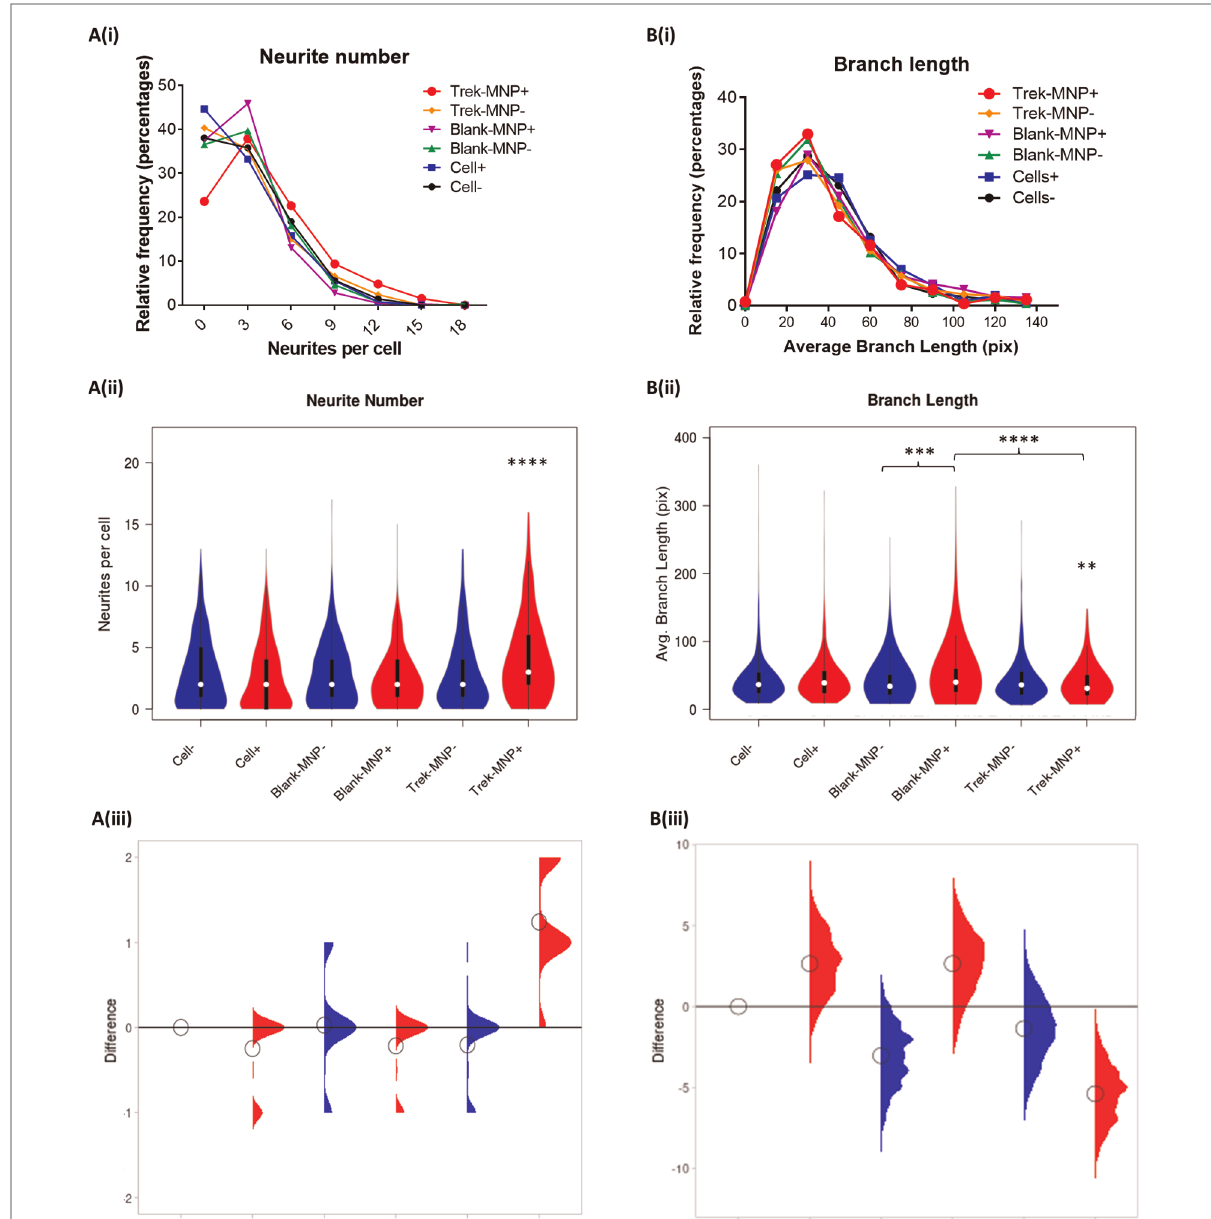
FIGURE 6 TREK-MNP increase neurite number and decrease branch length. Neurite analysis of Immuno fl uorescent images indicated that TREK-MNP with magnetic fi eld stimulation signi fi cantly increased the overall number of neurites per cell as shown by histogram ( A(i) ) and violin plots ( A(ii) ) whilst all other groups had no signi fi cant effect and remained similar to the control (cells only). The differences between the groups relative to the cells only control are shown by the median difference plots ( A(iii) ). Branch length analysis of neurites indicated that TREK-MNP (with magnetic fi eld stimulation) signi fi cantly decreased neurite branch length compared to the respective controls (cells+magnet and Blank-MNP+Magnet) as shown by histogram ( B(i) ) and violin plots ( B(ii) ). Blank-MNP+magnet marginally increased neurite branch length compared to Blank-MNP alone or TREK-MNP. The differences between the groups are shown by the median difference plots ( B(iii) ). Histograms and Violin plots represent median value (median denoted by white circles); box limits indicate the 25th and 75th percentiles; polygons represent density estimates of data and extend to extreme values. Differences between groups were compared using the non-parametric Kruskal-Wallis test, with Dunn ’ s post-hoc multiple comparison. A minimum of 271 cells were analysed for each